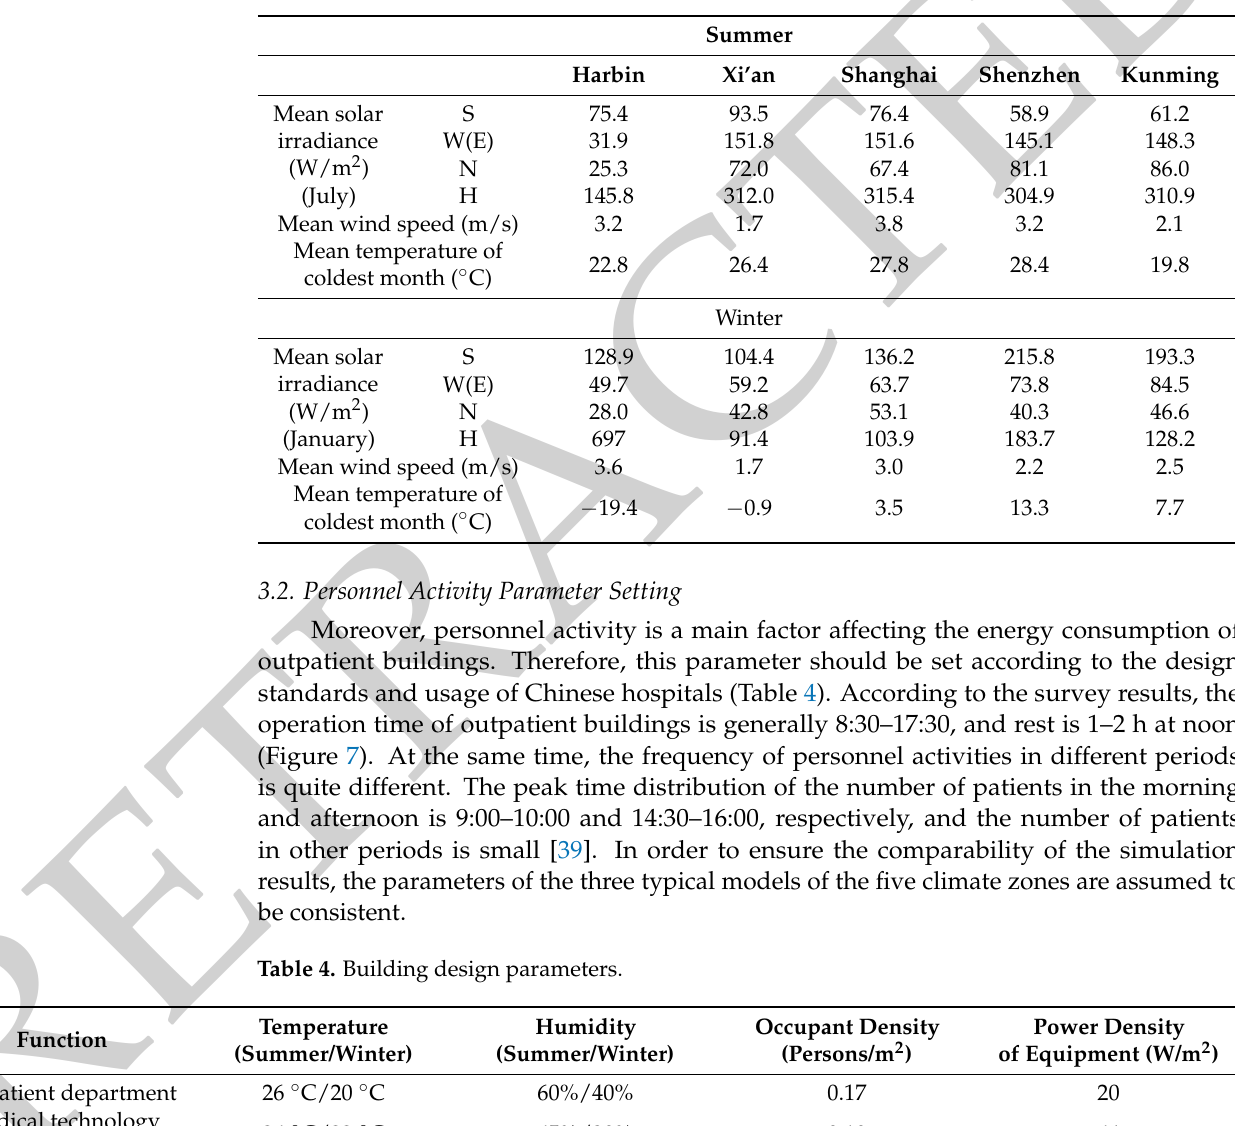
Table 3. Meteorological parameters of five selected cities.